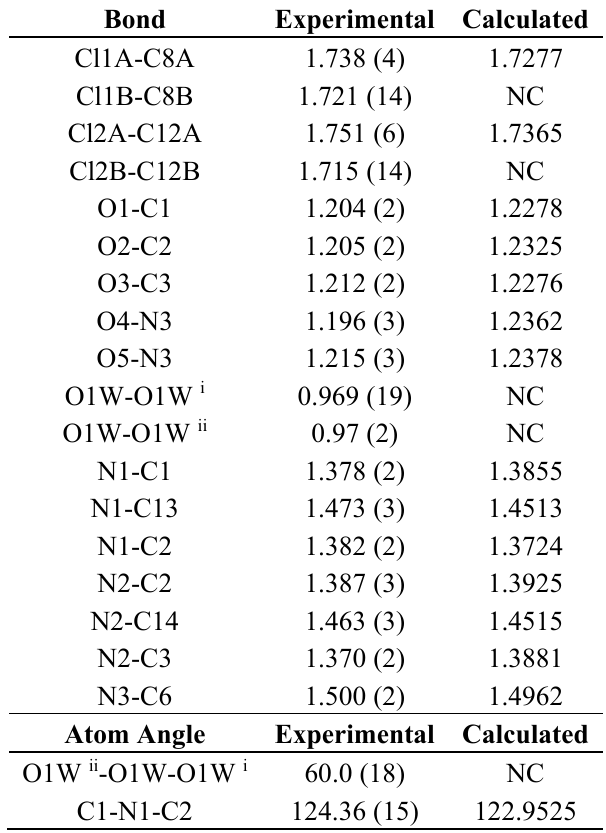
Table 4. Selected geometric parameters (Å, °) of compound 2a